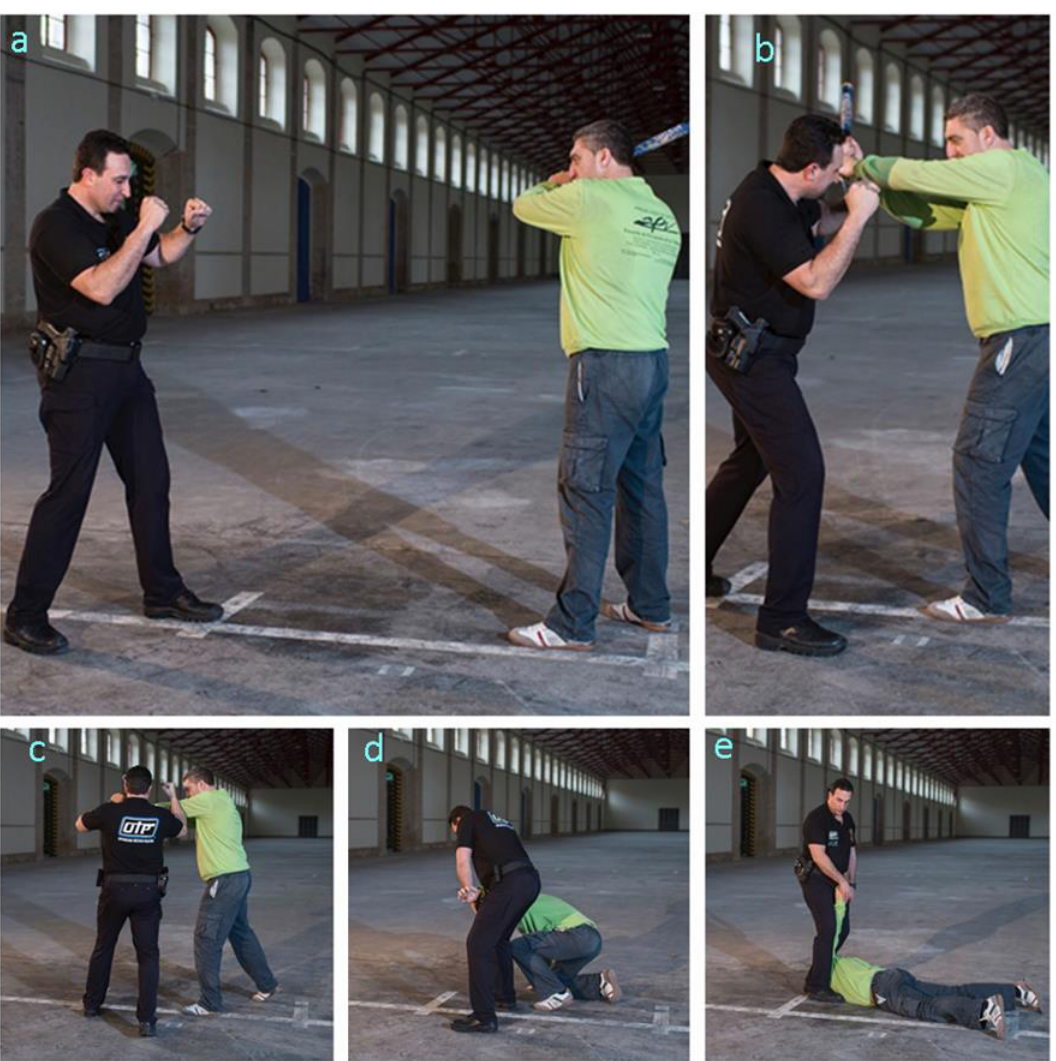
Figure 4. Steps of PIT 3 (response to a blunt object blow). ( a ) The officer faces the opponent holding a weapon. ( b ) The officer moves his left leg forward and uses his left forearm to block the opponent’s blow. ( c ) While grabbing the opponent, the officer uses his right forearm to hit the opponent’s elbow. ( d ) The officer uses his right forearm to exert pressure on the opponent’s triceps. ( e ) The opponent is subdued on the ground similarly as with Techniques 2 and 3.